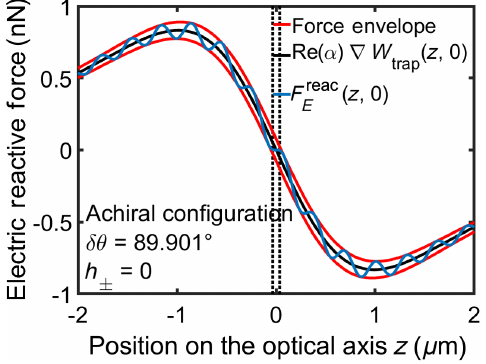
FIG. 11. Enlargement of the electric force landscape in the achiral case, keeping in mind that the magnetic force is practically zero. This landscape is modified by the chiral forces when the helicity parameters h (cid:1) are nonzero. As in Fig. 10, the black line represents the force deriving from the trapping potential − Re ½ α (cid:3) ∇ W ð z; q Þ . This force carries the contribution of the trap ð z; q Þ due to the interplay interference potential − Re ½ α (cid:3) ∇ W inter between the two counterpropagating beams. The total reactive electric force generated by these two components is represented by the blue line. Finally, the red line is the envelope of the electric forces. In the main text, we consider the nanospheres trapped at the center of the well at z ¼ 0 , with Fig. 3(b) displaying the force landscape evaluated between the dotted black lines. There is locally a double well caused by the oscillation due to the interference force around z ¼ 0 . In this configuration, we have only two wells, due to the fact that the interference forces are not strong enough to generate other trapping locations, as can be seen by the fact that they do not cross 0 except at the center, and this despite their varying